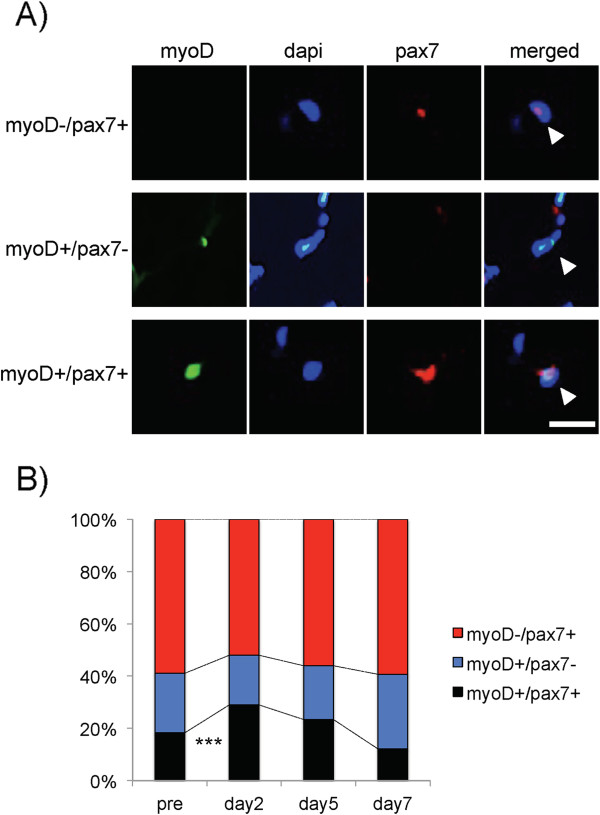
Typical photomicrographs showing the localizations of myoD and pax7 at day 2 and their quantifications. Triple immunostaining (A) of myoD (green), laminin (red), nuclei (blue), and merge for myoD-negative/pax7-positive, myoD-positive/pax7-negative, and myoD-positive/pax7-positive. Arrows indicate immunoreactive positive regions. Bar = 30 μm. The graph (B) shows the percentages of myoD-negative/pax7-positive cells (red bar), myoD-positive/pax7-negative (blue bar), and myoD-positive/pax7-positive (black bar). ***: p < 0.001, compared to pre-treatment and day 7 levels of the percentages of myoD-positive/pax7-positive cells.